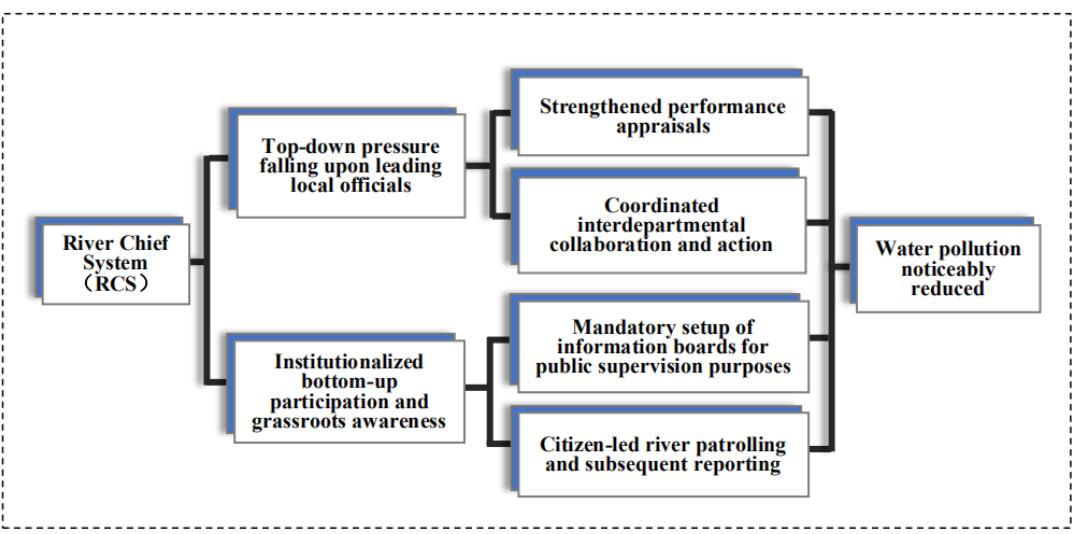
Figure 1. Theoretical Framework.